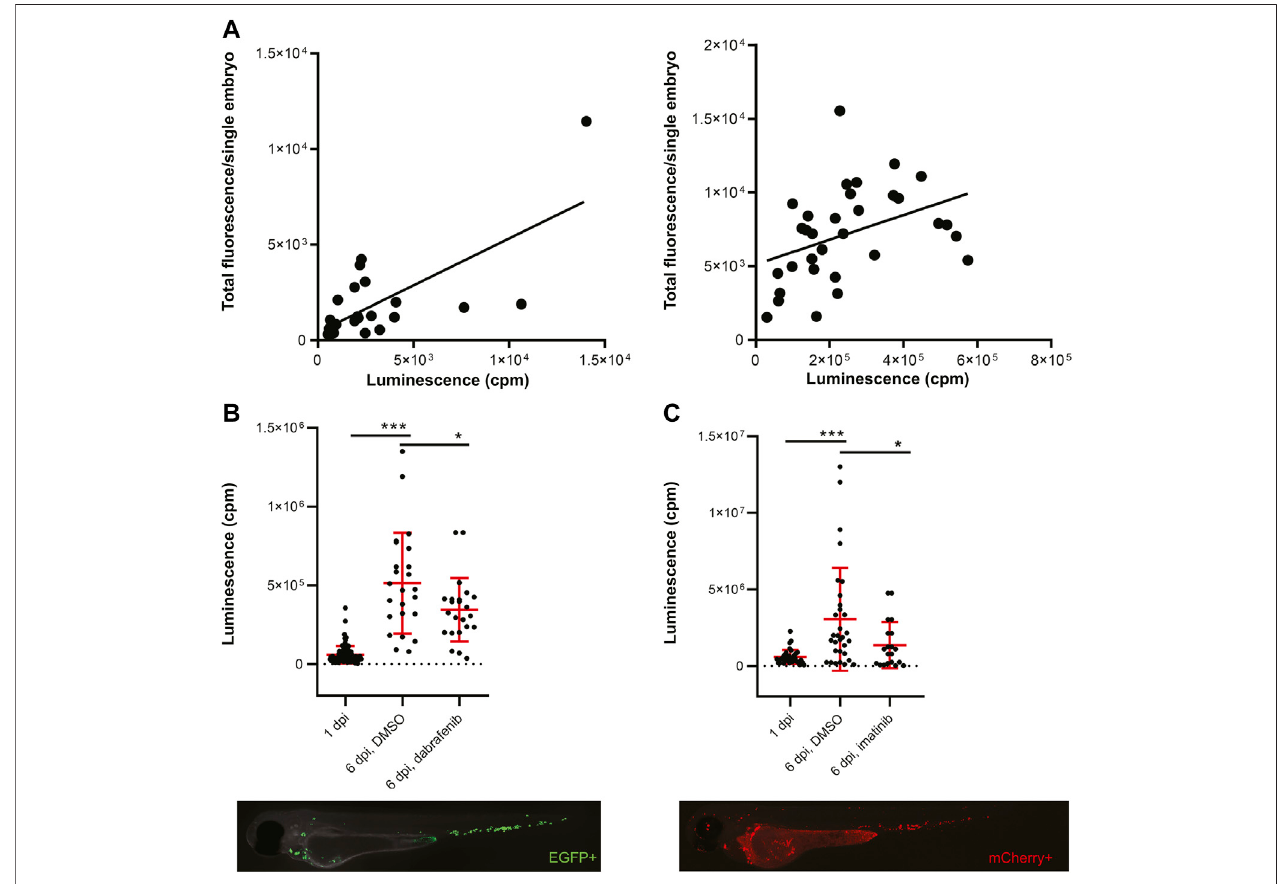
FiGURE 1 | Transplanted cancer cells survive in vivo in zebra fi sh embryos and their growth can be inhibited by small molecules. (A) Correlation of fl uorescence to luminescence as measured in transplanted zebra fi sh embryos at 1 day post-injection (dpi). Every dot is a readout from a single embryo. On the left, the correlation of EGFP to NanoLuc in ZMEL1 is shown [slope is signi fi cantly non-zero, p = 0.0001, Goodness of fi t (R) = 0.4916]. On the right, the correlation of mCherry to NanoLuc in K562 is shown [slope signi fi cantly non-zero, p = 0.0251, Goodness of fi t (R) = 0.1563]. (B) Growth and drug inhibition of growth of ZMEL1 cells in zebra fi sh embryos, 1 – 6 dpi. ZMEL1 cells grew signi fi cantly in vivo from 1 to 6 dpi. The growth was signi fi cantly inhibited by a BRAF inhibitor, dabrafenib. Below, there is a representative image ofa1 dpi casper , prkdc − / − zebra fi shembryo transplanted withgreenZMEL1- EGFP - NLuc cells,imagedinthegreenGFP channel. (C) Growthand drug inhibition of growth of K562 cells in zebra fi sh embryos, 1 – 6 dpi. K562 cells grew signi fi cantly in vivo from 1 to 6 dpi. The growth was signi fi cantly inhibited by imatinib.Below,thereisarepresentativeimageofa1 dpi casper , prkdc − / − zebra fi shembryotransplantedwithredK562- mCherry - NLuc cells,imagedintheredmCherry channel. (B,C) Statistical signi fi cance was determined by unpaired two-tailed t -test. * p < 0.05 *** p < 0.001. Luminescence measured in vivo in single embryos is represented by a single dot in dot plots. Fluorescence images were acquired on Zeiss AxioZoom.V16 with Axiocam-506 mono camera and the ZEN Blue